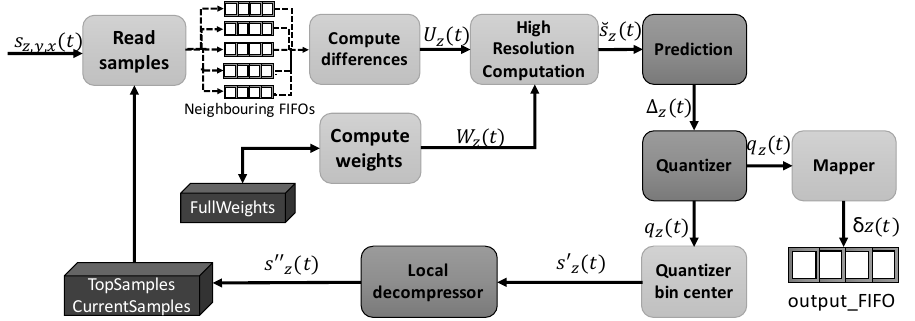
Figure 4. Block diagram of the predictor